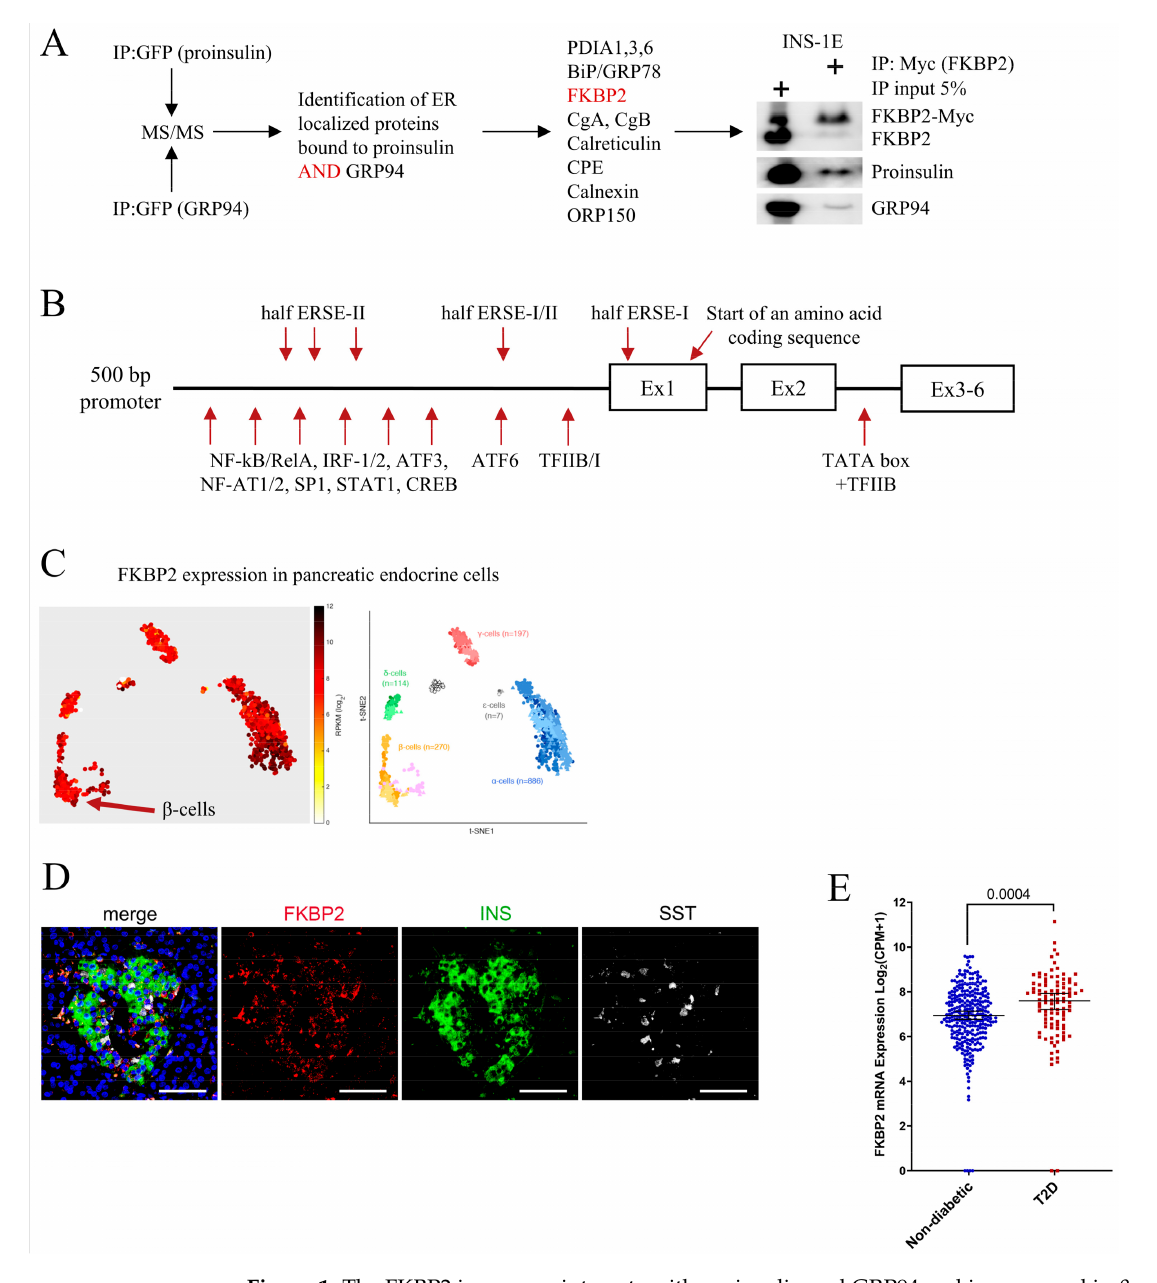
Figure 1. The FKBP2 isomerase interacts with proinsulin and GRP94 and is expressed in β -cells. ( A ). INS1-E cells were transiently transfected to express GFP-tagged human proinsulin or GRP94, both of which were immunoprecipitated and analyzed by mass spectrometry for binding partners present in the endoplasmic reticulum. FKBP2’s interaction with proinsulin and GRP94 was confirmed by SDS-PAGE/Western blot analysis of the immunoprecipitates of myc-tagged FKBP2 expressed in INS1-E cells. PDIA 1, 3, 6: Protein disulfide-isomerase 1, 3, 6; BiP/GRP78: binding immunoglobulin protein/Glucose Regulated Protein 78; CgA, CgB: chromogranin A and B; CPE: carboxypeptidase E; ORP150: oxygen-regulated protein 150. ( B ). Graphic representation of the FKBP2 promoter with putative transcription factor binding sites and regulatory elements identified using PROMO from ALGGEN. Analyzed DNA sequence was retrieved from HGNC:3718. ERSE: ER stress response element; TFIIB/I: transcription factor IIB/I; ATF6 and 3: activating transcription factor 6 and 3; NF-kB/RelA: nuclear factor-kB/REL-associated protein; IRF-1/2: interferon regulatory factor 1/2; NF-AT1/2: nuclear factor of activated T cells; SP1: Specificity Protein 1; STAT1: signal transducer and activator of transcription 1; CREB: cAMP response element-binding protein; Ex: exon. ( C ).